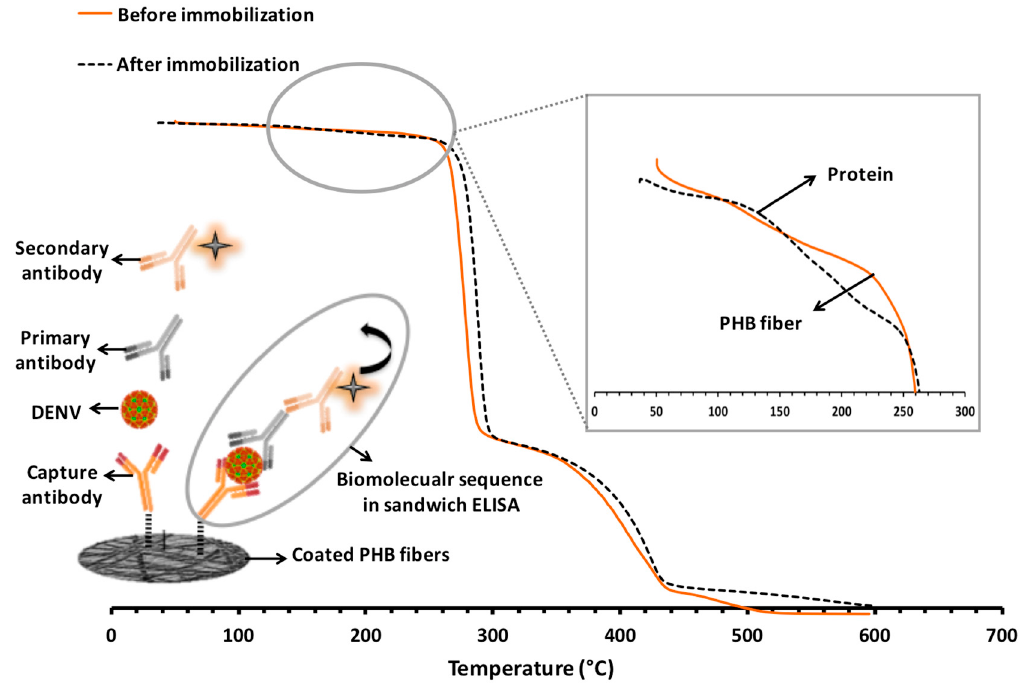
Figure 3. Thermal analyses of the coated PHB fibers before and after protein immobilization, along with a schematic representation of the sandwich ELISA that takes place on the surface of the coated fibers and leads to the final detection signal; inset is the zoomed in region between 0° C and 300° C showing the onset of degradation for proteins, as well as PHB fibers.